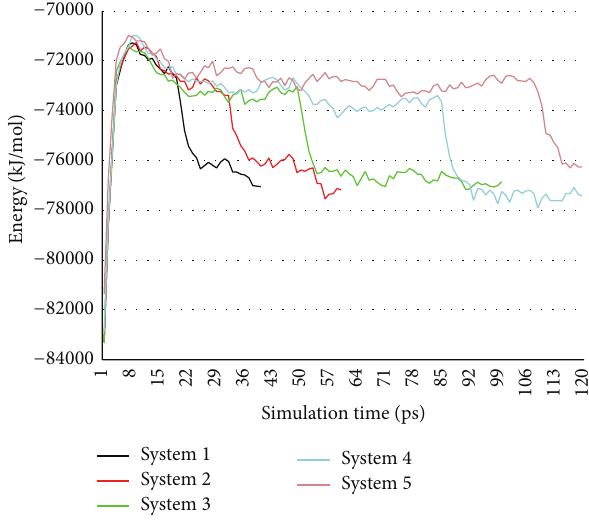
Figure 10: RDF curves of Fe-H 2 O of system 3 in key